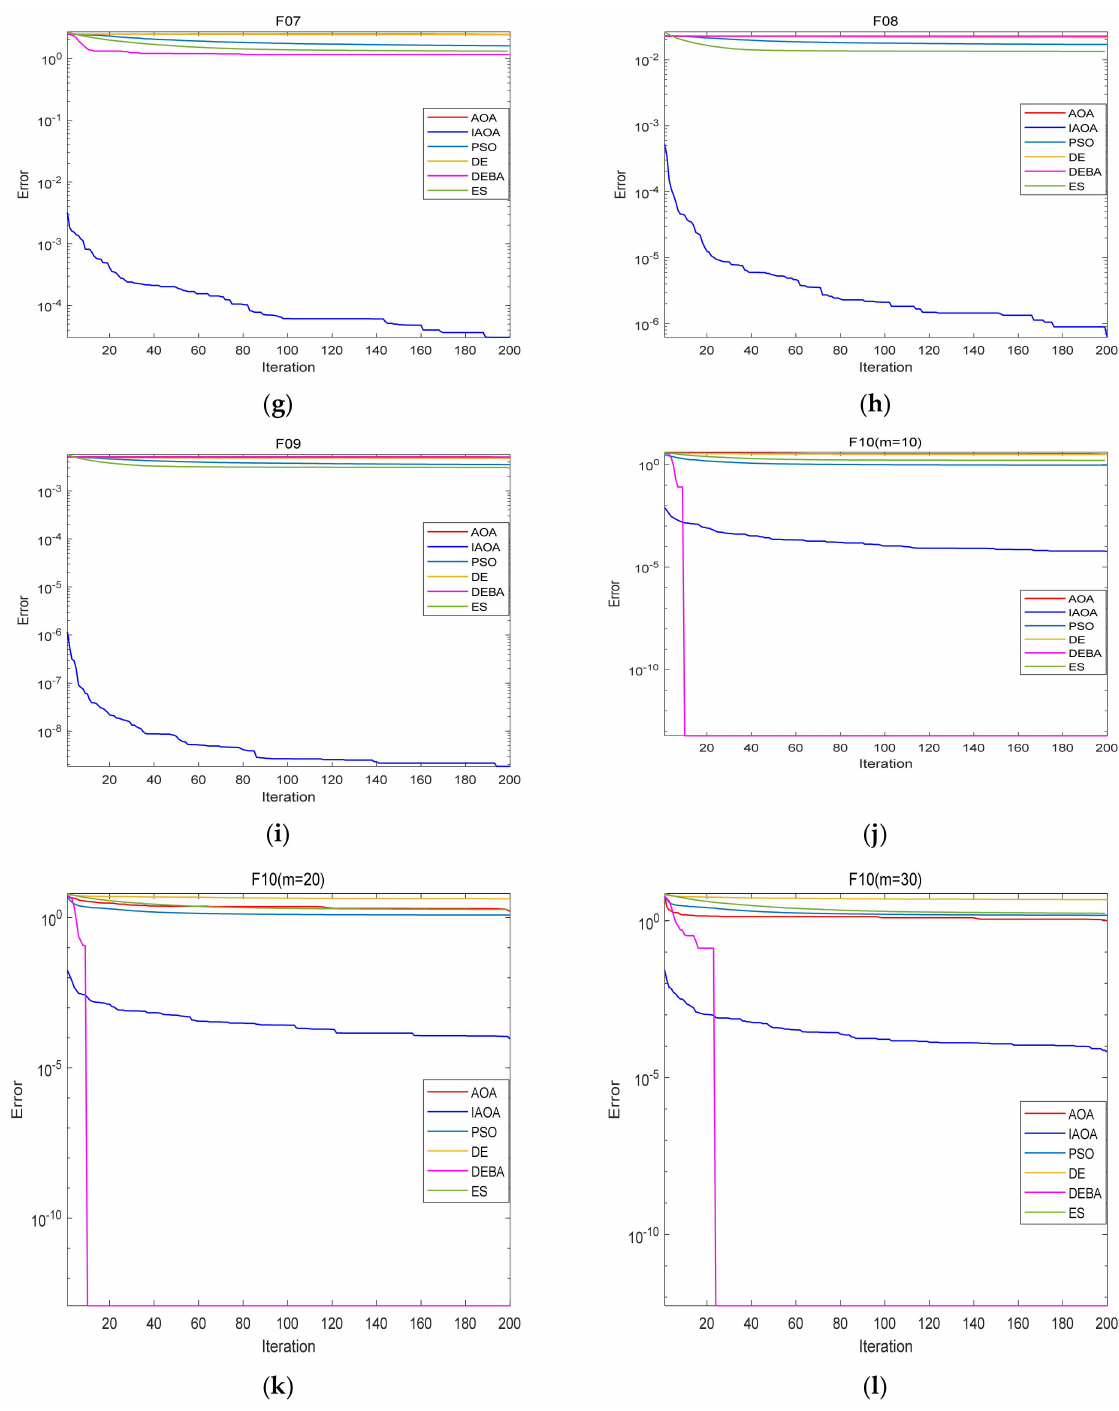
Figure 5. Convergence curve for the numerical integrations (F01–F10 ( a – l